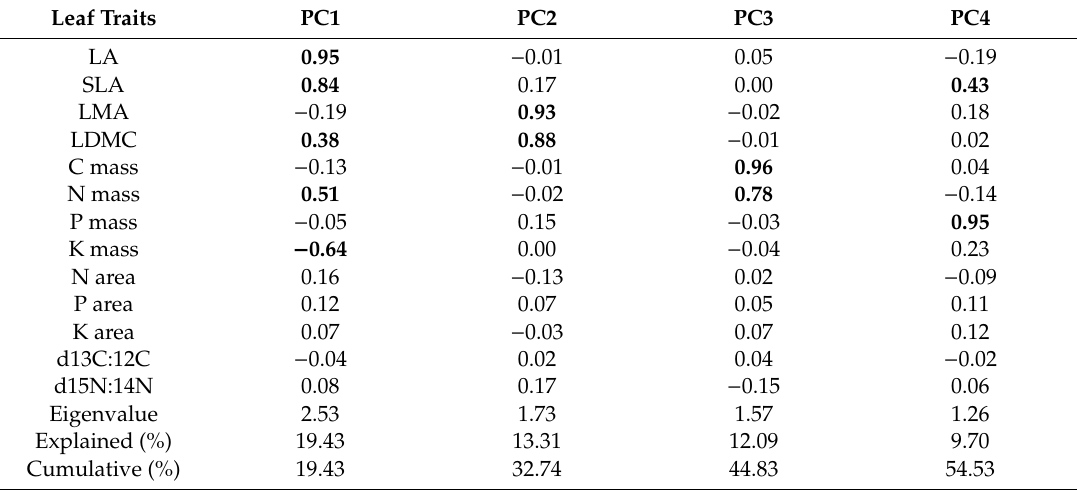
Table 3. Trait loadings, eigenvalues, and the percentage of trait variation explained by Principal components analysis